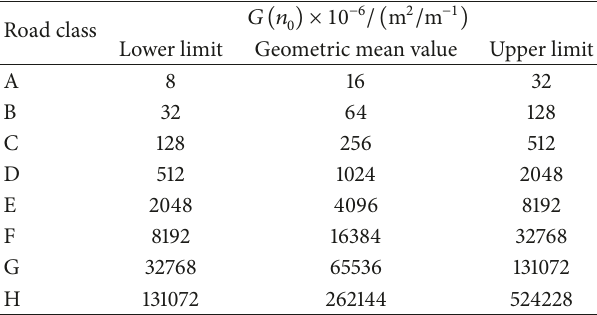
Table 4: Different roads